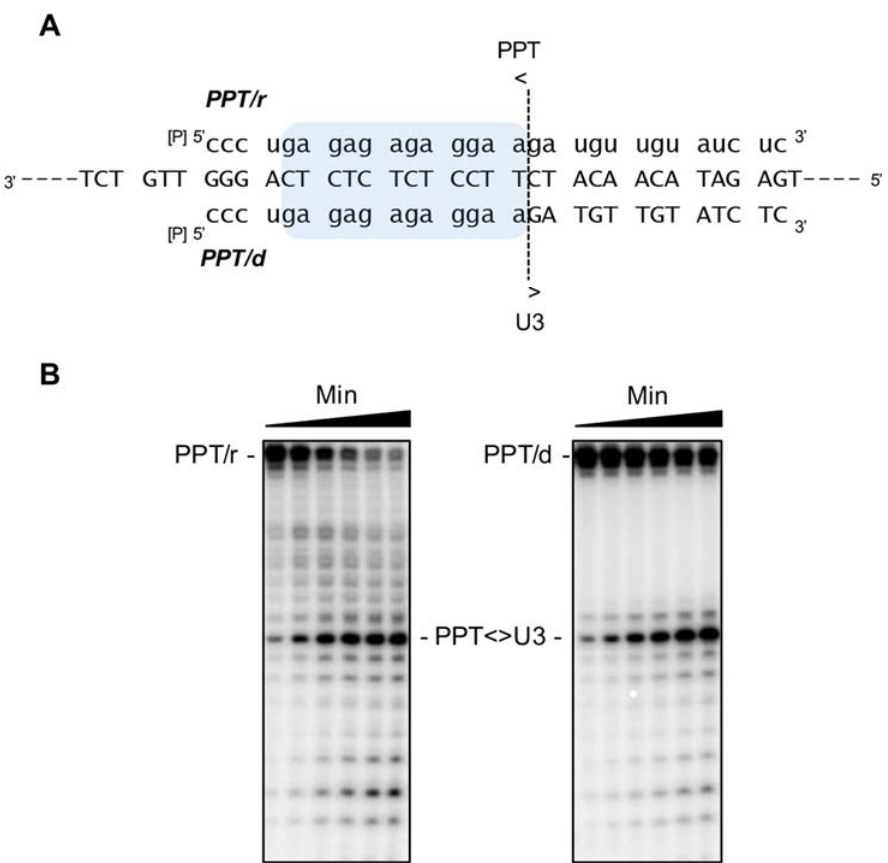
Figure 7. ( A ) Model RNA/DNA hybrids to illustrate the specificity of cleavage at the Ty3 PPT/U3 junction. A hybrid containing the “all-RNA” strand, PPT/r, mimics selection of the PPT 3’-OH from the RNA/DNA replication mediate during ( − ) strand DNA synthesis, while a hybrid containing the RNA-DNA chimera, PPT/d, mimics release of the PPT 3’-OH from nascent DNA, an obligate step following initiation of (+) strand DNA synthesis; ( B ) experimental data. For both model substrates, the position of the PPT/U3 junction has been indicated. Adapted from [50].